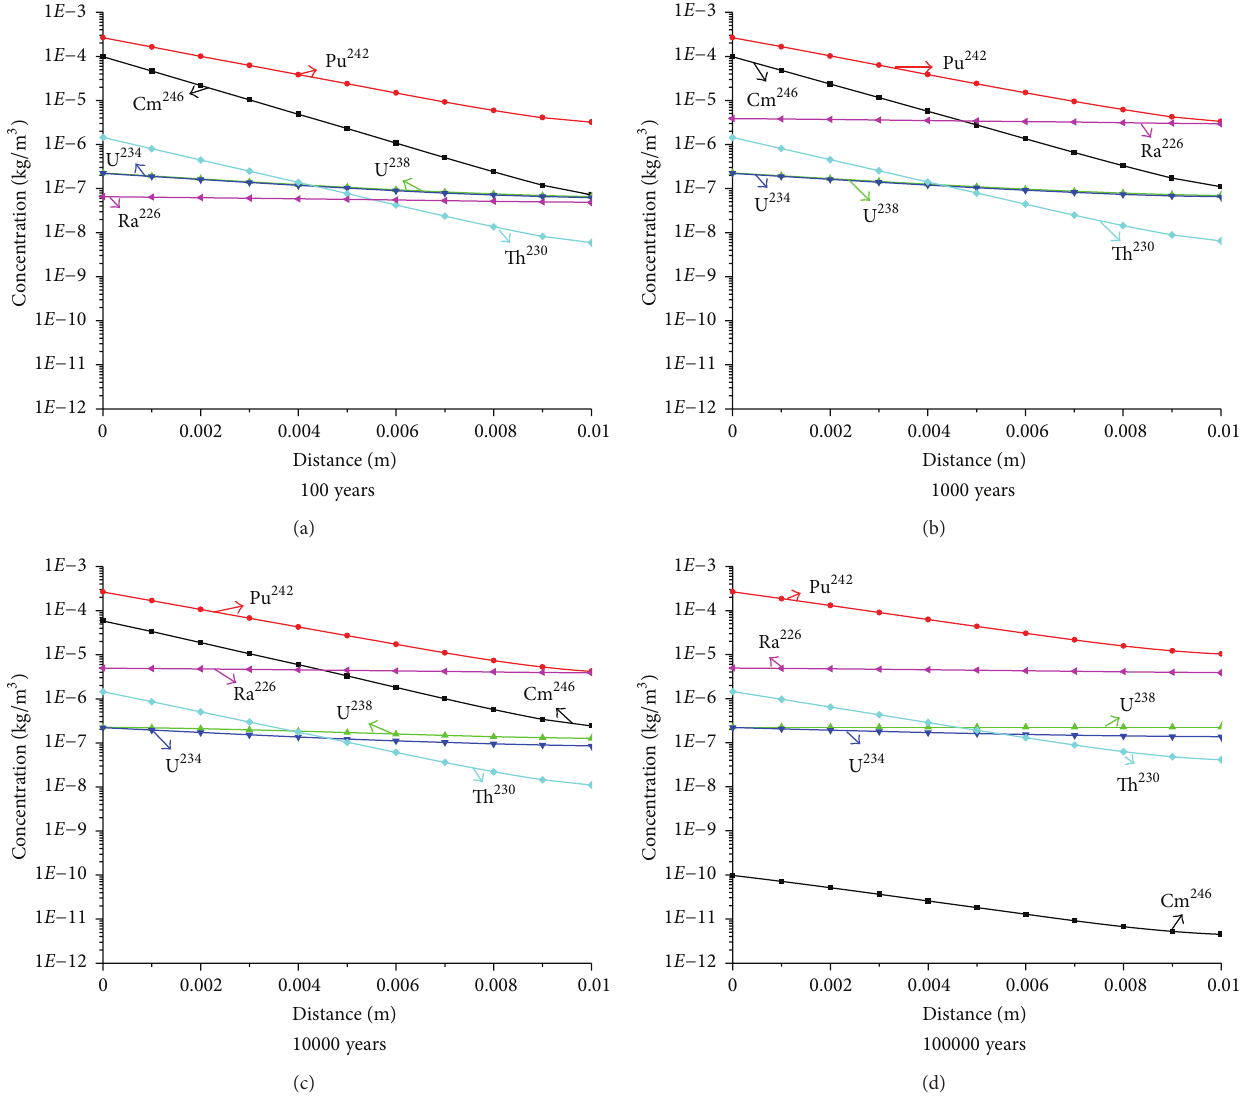
Figure 9: Concentration profiles in extruded bentonite region, for nuclides of 4 𝑛 + 2 chain (Cm 246 → Pu 242 → U 238 → U 234 → Th 230 → Ra 226 ) for 10 2 , 10 3 , 10 4 , and 10 5 years.